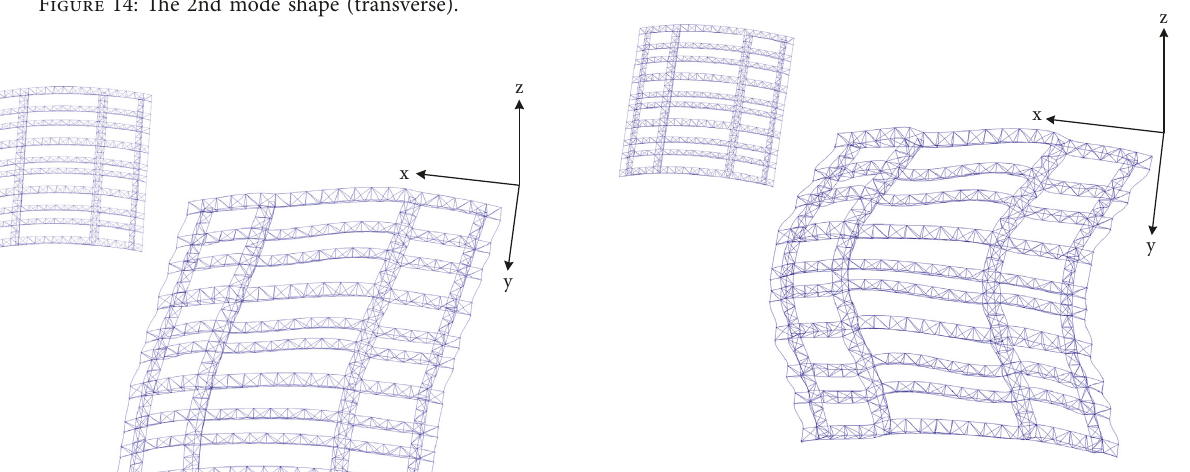
Figure 18: The 6th mode shape (transverse). Table 1: The mass participation factors of the first 6